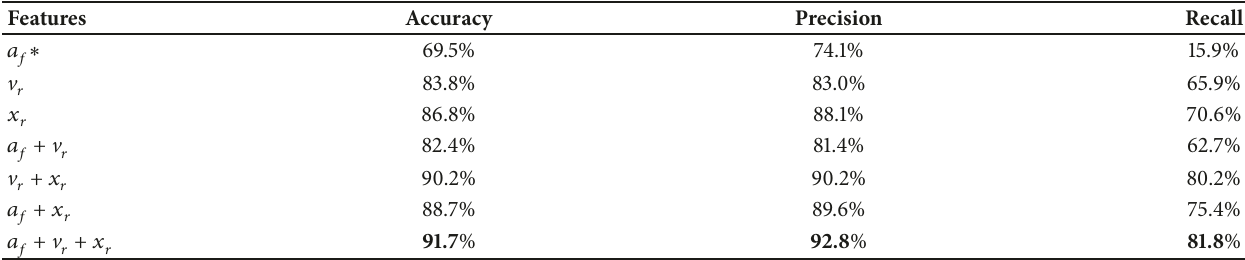
Table 6: The evaluation results of driving style based on SVM using DWT.